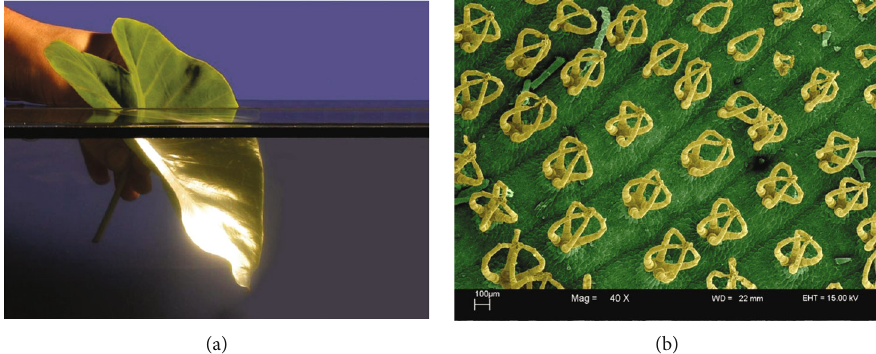
Figure 2: (a) Silver light is caused by air trapped between blade surface structures, and (b) surface multicellular, with coronal shape [24].